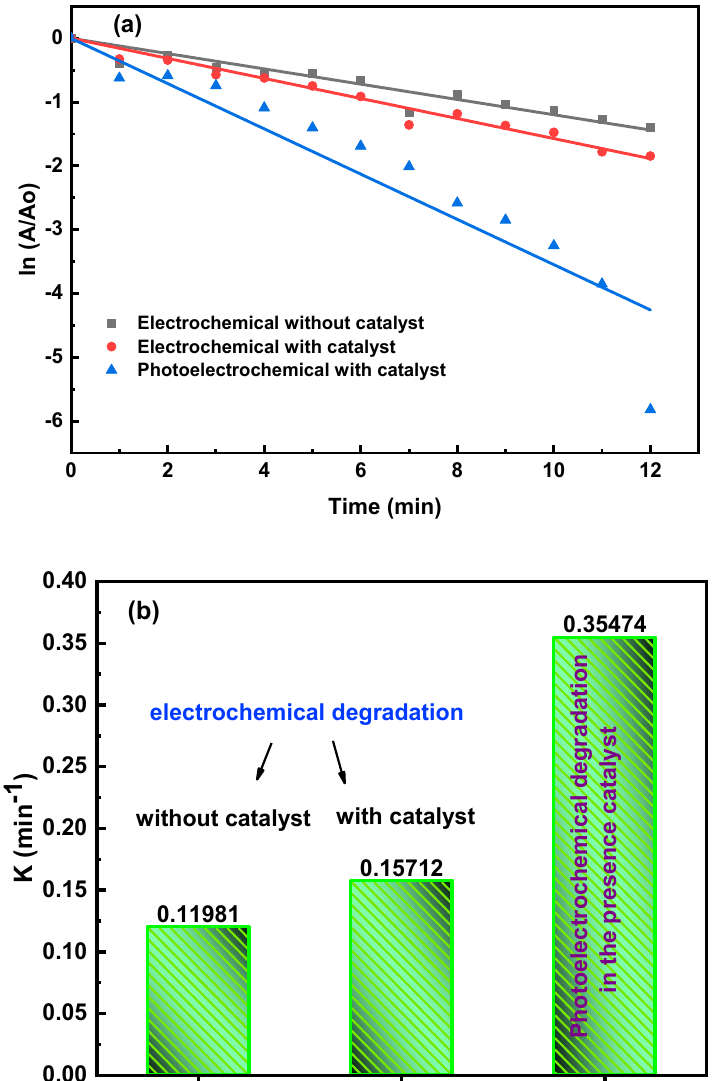
Figure 11. ( a ) Kinetic plots and ( b ) rate constant values of the electrochemical degradation reaction of carmine in the absence of the catalyst, in the presence of 0.001 g of G/N-doped ZnO, and photoelectrochemical degradation reaction of carmine in the presence of 0.001 g of G/N-doped ZnO nanocomposite after a time interval of 15 min.